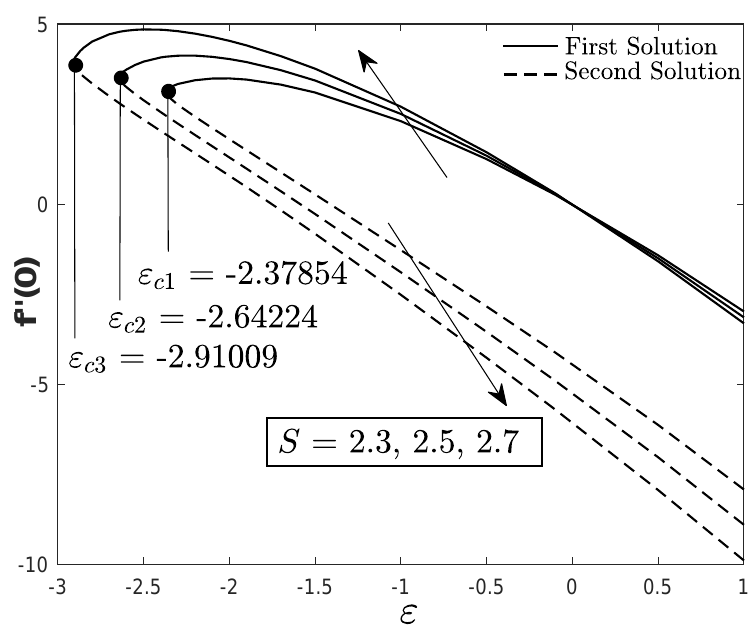
Figure 2. f (cid:48)(cid:48) ( 0 ) versus ε for various values of suction S .